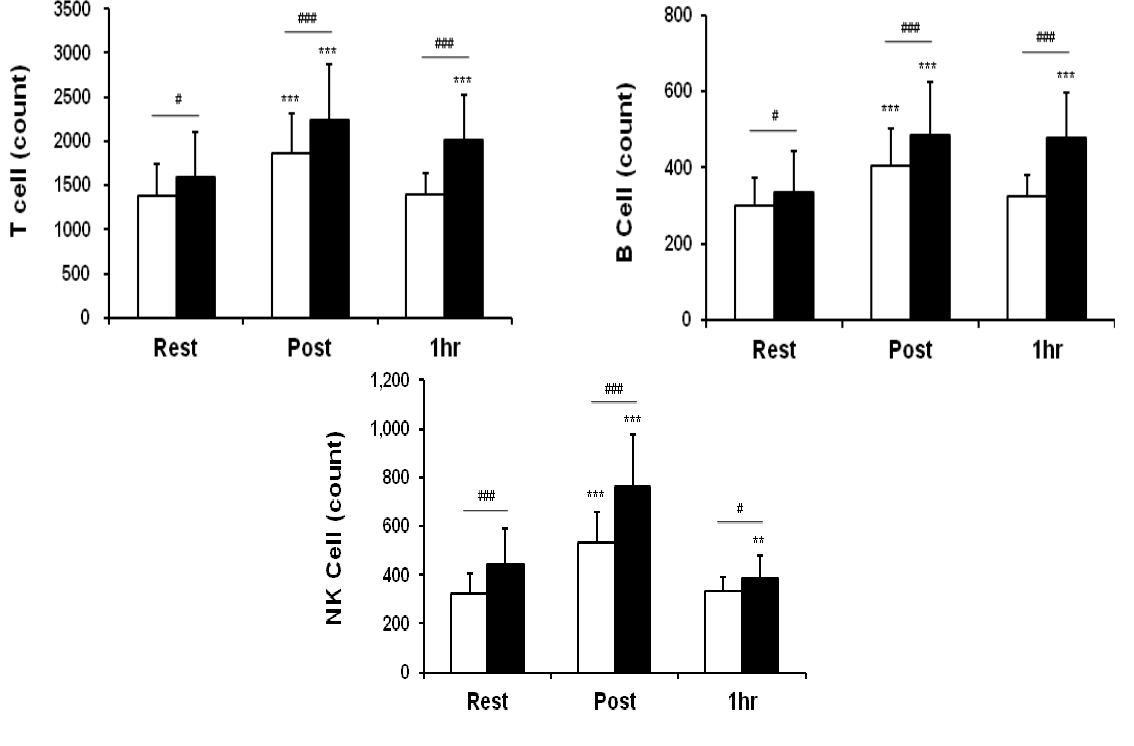
Figure 3. Lymphocyte subset counts over time in two groups. Rest: before heating; Post: immediately after heating; 1 h: 1 h after heating. White columns indicate placebo intake, and black columns, oligonol intake. Values are presented as the mean ± standard deviation. ** p < 0.01 and *** p < 0.001 indicate significant differences in comparison to Rest within the same group, and # p < 0.05 and ### p < 0.001 indicate significant differences between two